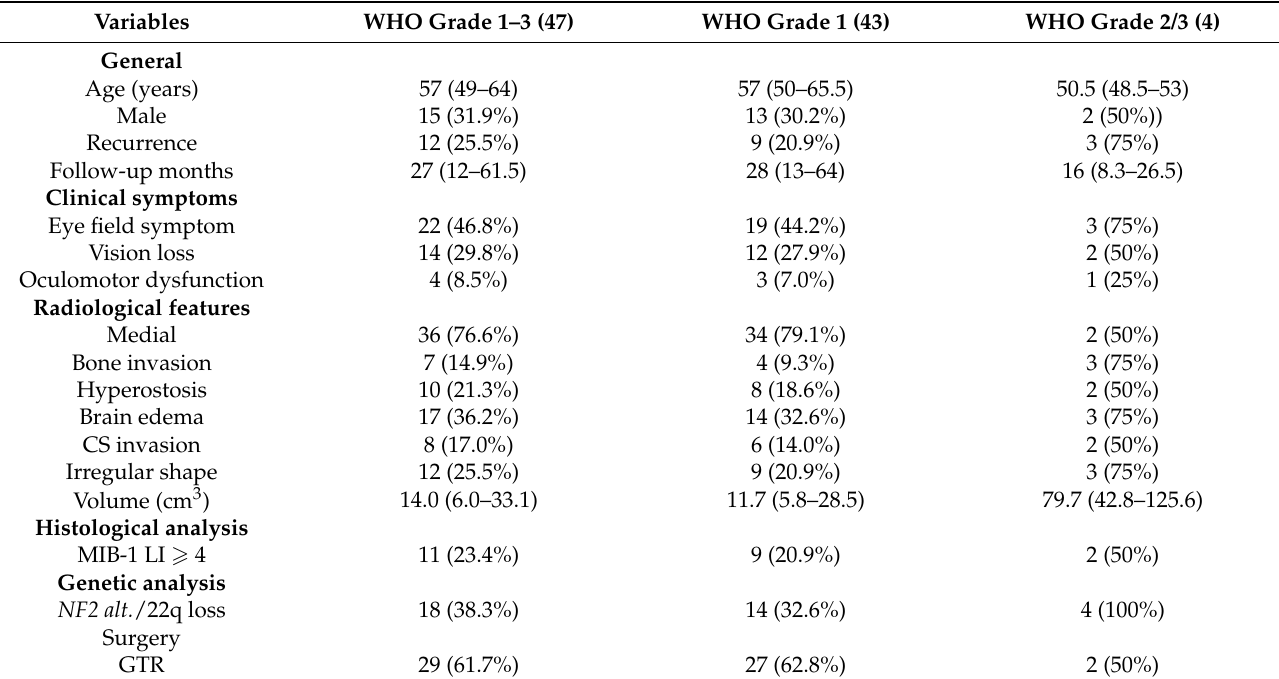
Table 1. Patient